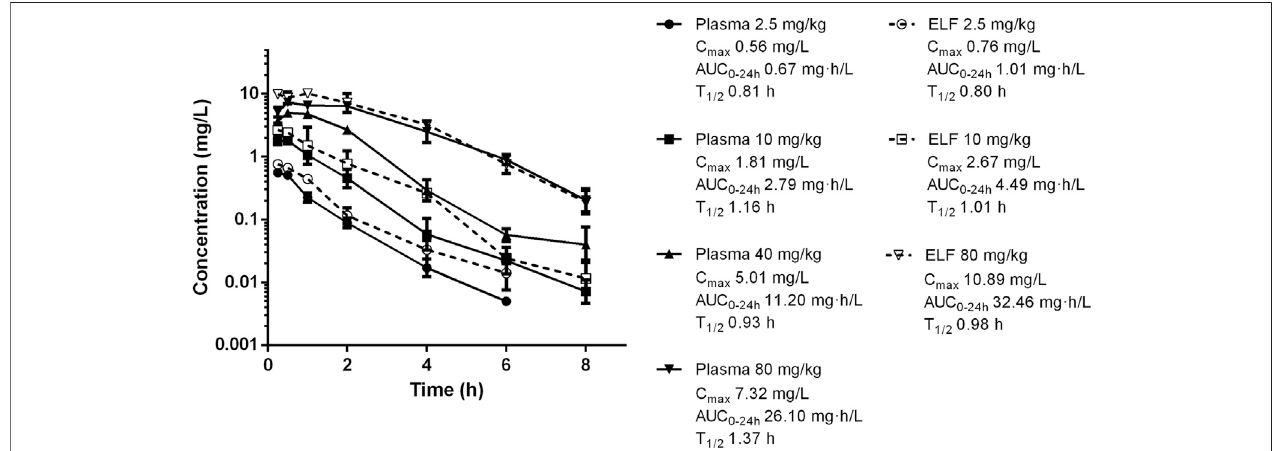
FIGURE 1 | Pharmacokinetics of nemonoxacin in plasma and epithelial lining fl uid (ELF) following single subcutaneous doses at 2.5 – 80 mg/kg in neutropenic lung infected mice. Plasma was sampled at doses of 2.5, 10, 40 and 80 mg/kg. ELF was studied at doses of 2.5, 10 and 80 mg/kg. Groups of three mice were sampled for each time point. Each symbol represents the mean value of three mice. The error bar represents the standard deviations. Pharmacokinetic parameters including maximum drug concentrations (C max ), the AUC from 0 to 24 h (AUC 0-24 ), and elimination half-life (T 1/2 ) for each